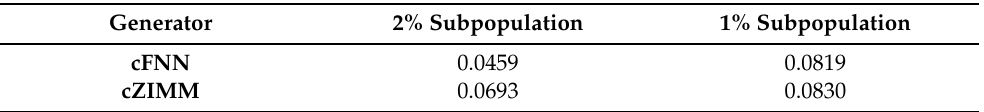
Table 3. cFNN and cZIMM for the cases of 2% and 1% rare population (RBF kernel, σ = 5). The baseline MMD score calculated over the test set and 50 randomly chosen equally-sized training sets and is equal to & 0.016 ± 0.004. Lower MMD value is